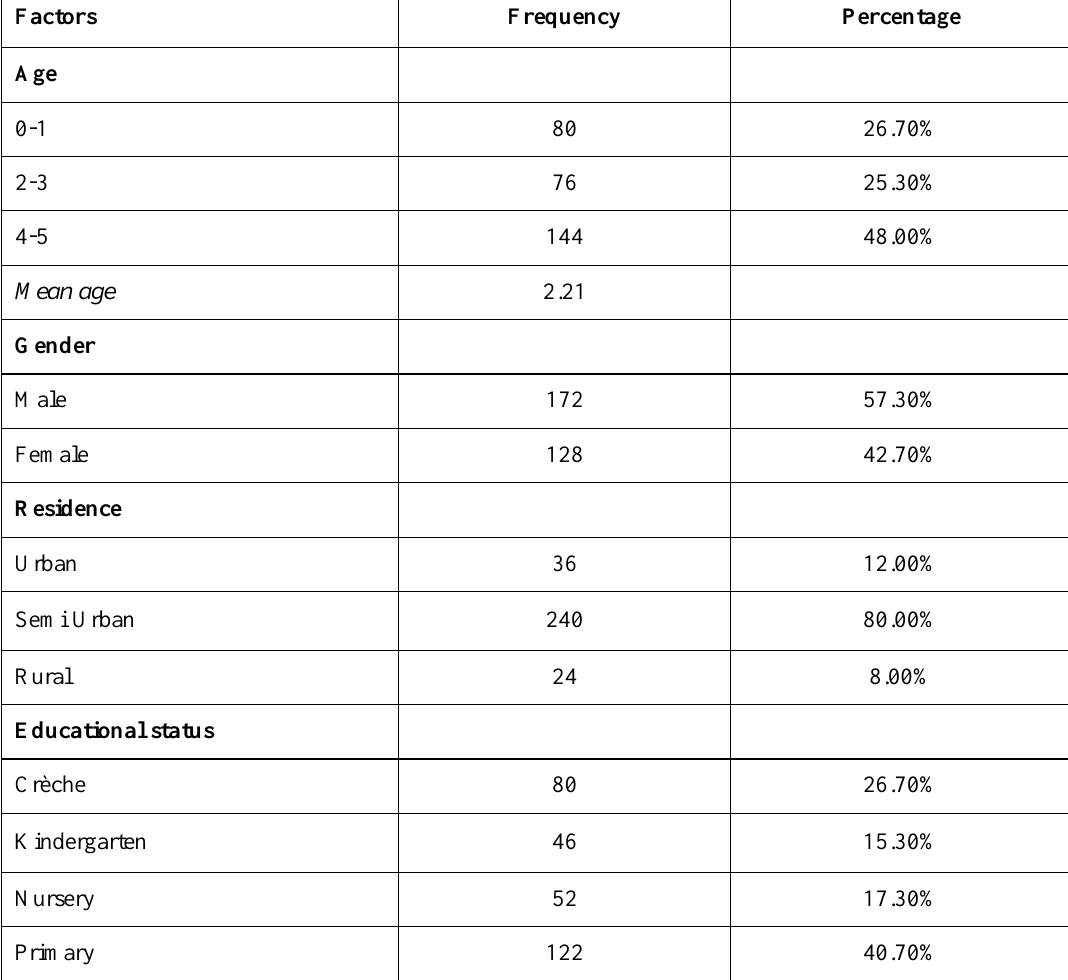
Table 1. Socio-demographic characteristics of the